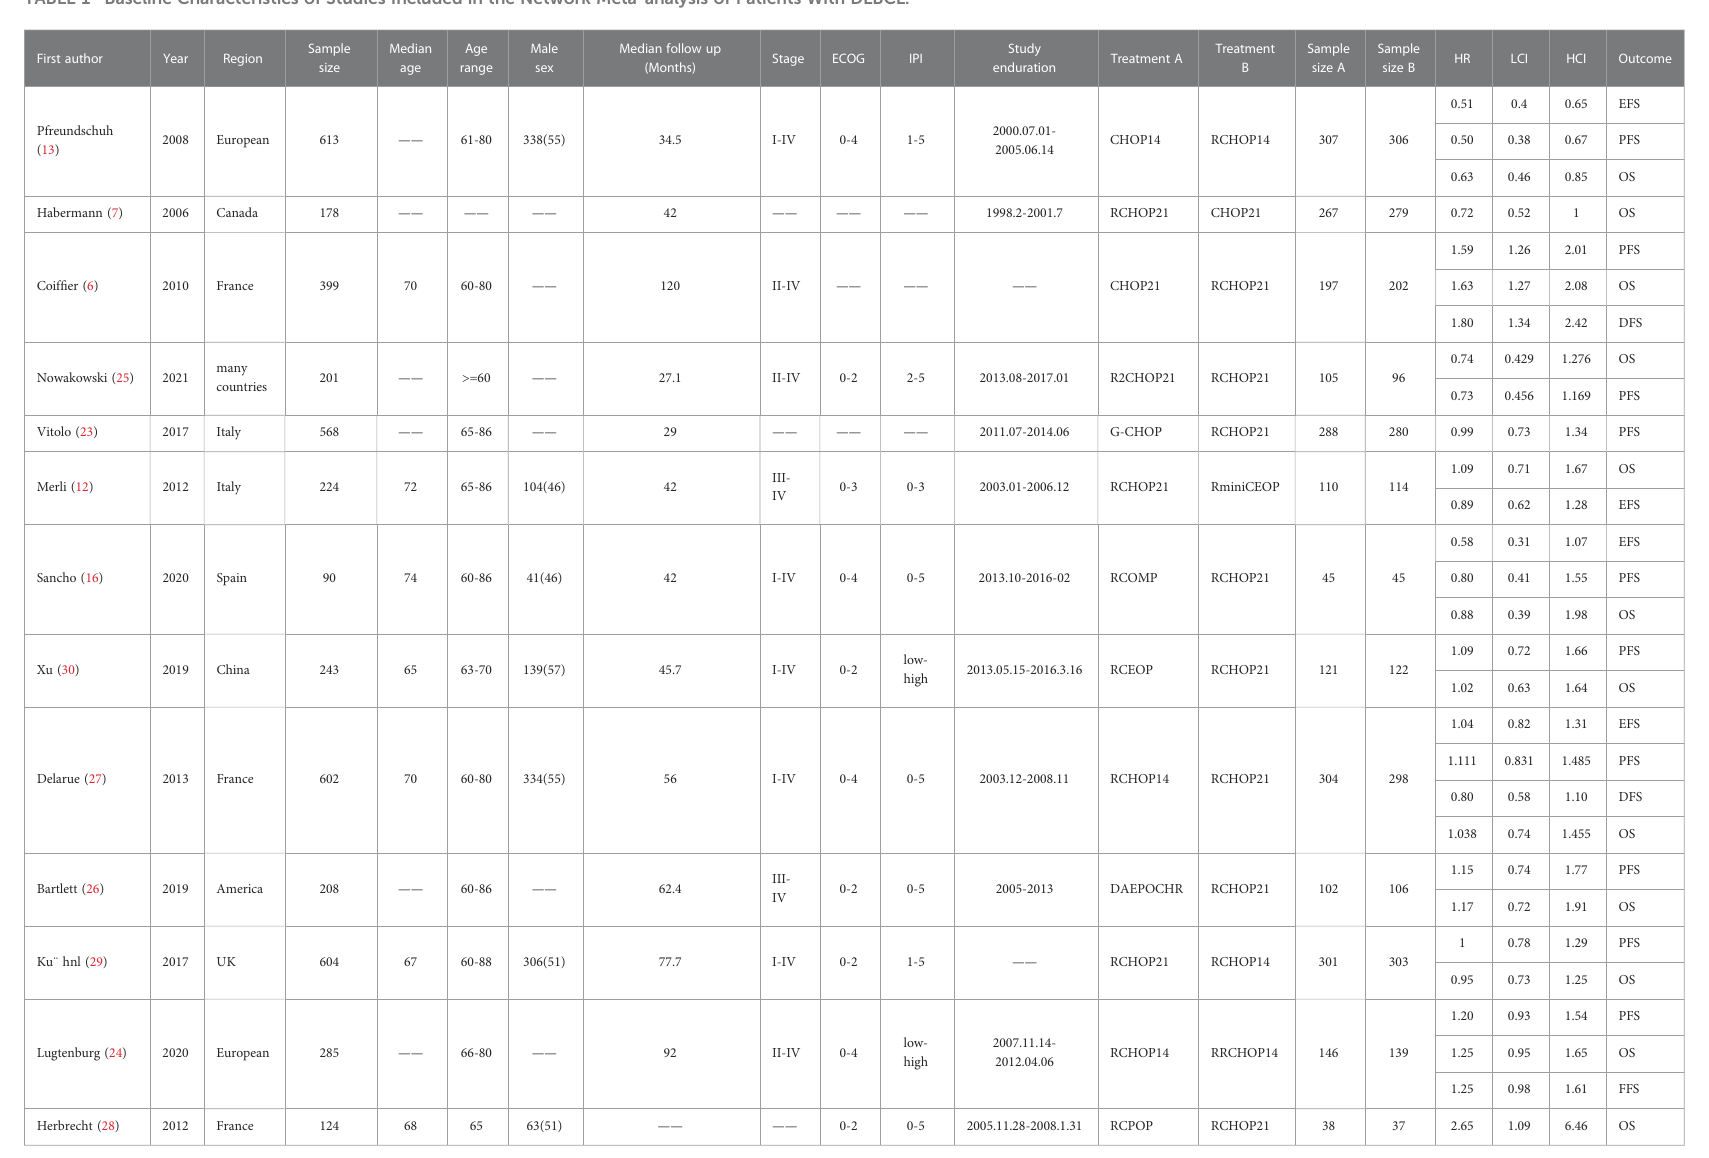
TABLE 1 Baseline Characteristics of Studies Included in the Network Meta-analysis of Patients With